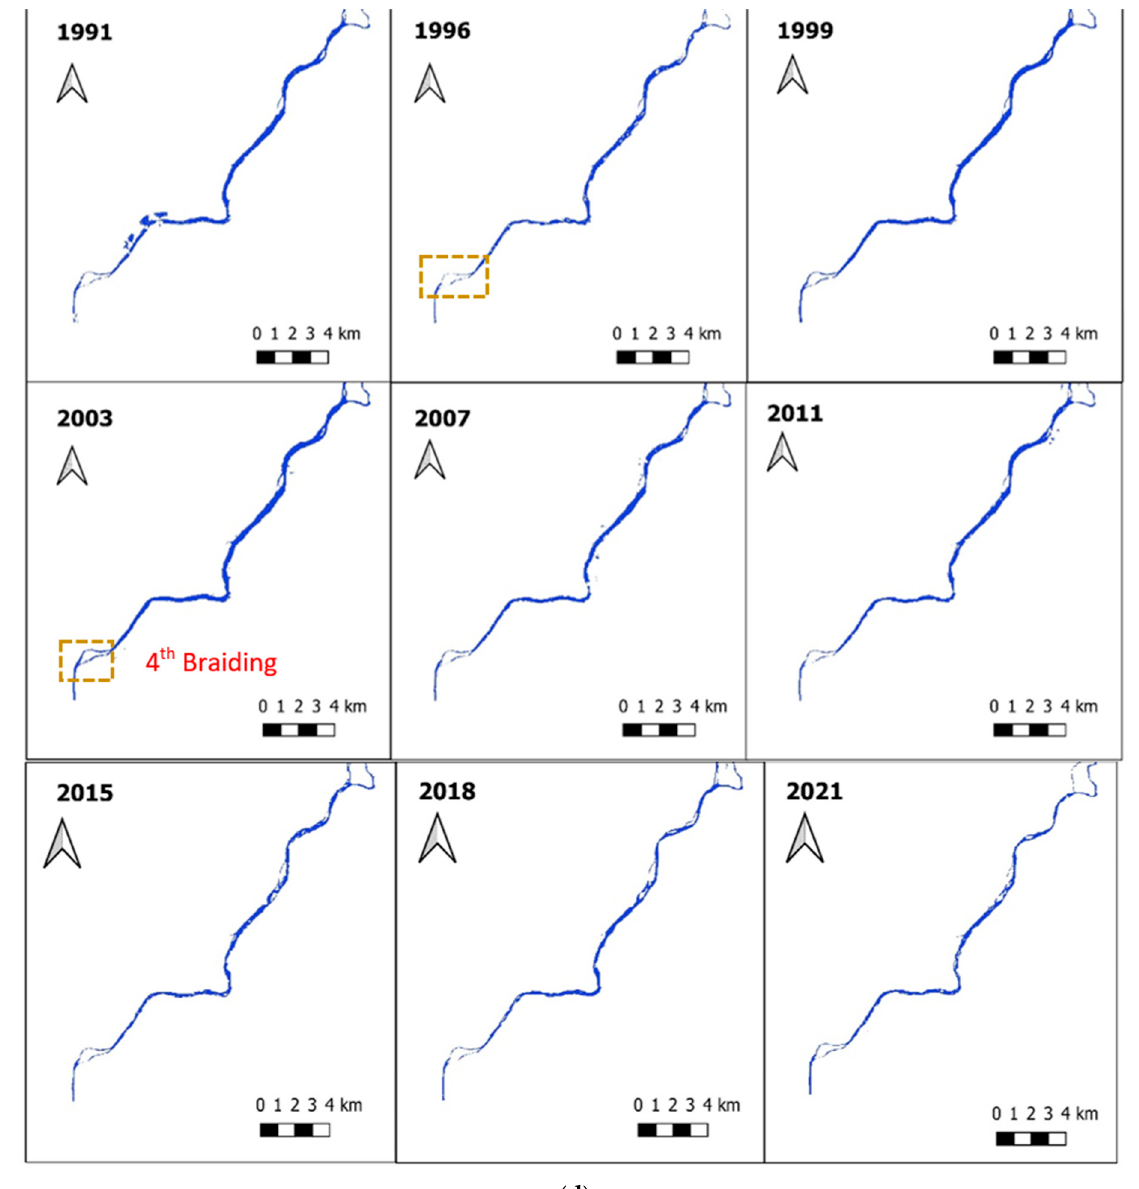
Figure 6 . River masks generated for the Mahaweli River from Damanewewa to Trincomalee: ( a ) Most downstream river part of the selected Mahaweli River stretch near to Trincomalee; ( b , c ) middle stretches of the selected river segment; ( d ) most upstream part of the selected river stretch starts from Damanewewa .